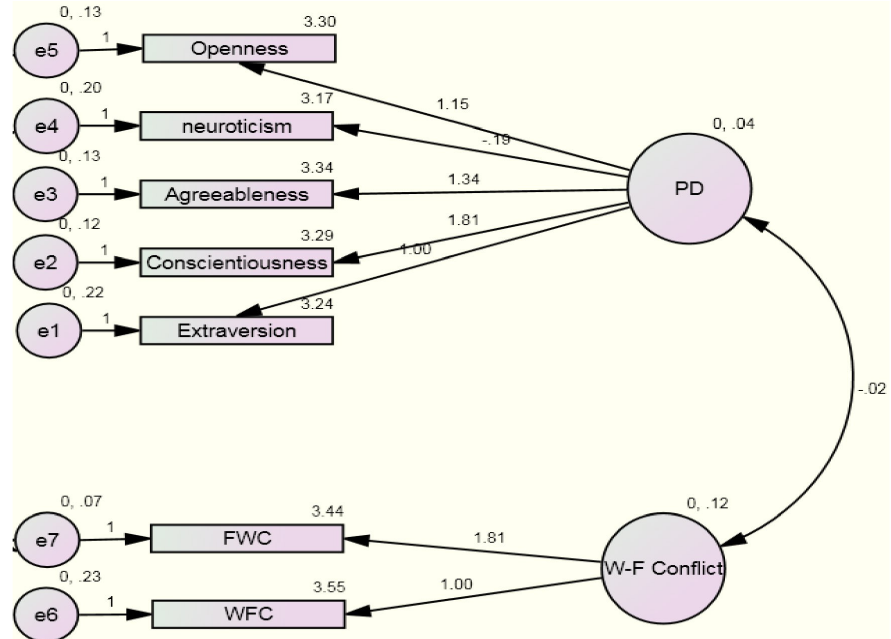
Figure 2. Showing the hypothesized model with estimates extracted by running Confirmatory Factor Analysis (CFA)